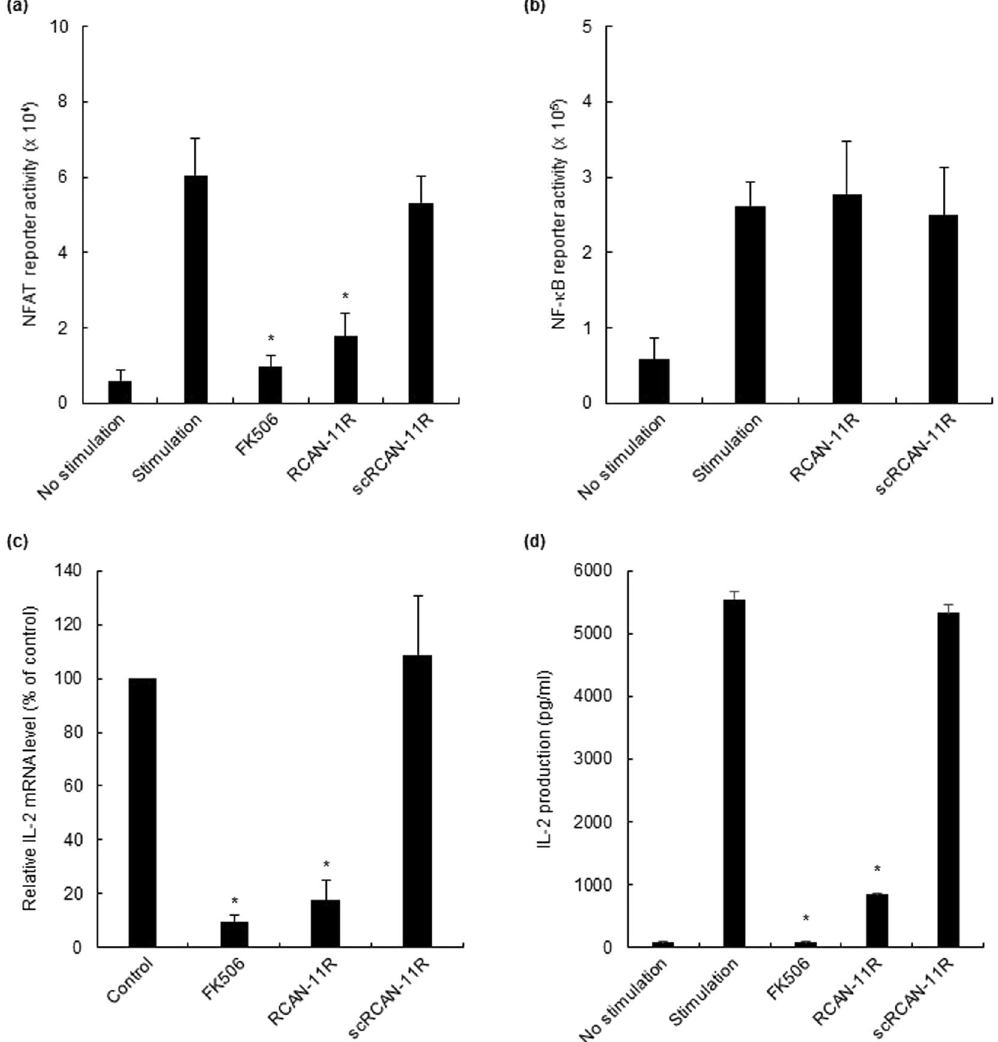
Figure 2. The inhibition of NFAT reporter activity and the production of IL2. ( a , b ) NFAT ( a ) and NF- κ B ( b ) reporter activity. Jurkat cells were electroporated with 5 μ g of pNFAT-SEAP or pNF- κ B-SEAP, respectively. The cells were incubated with 1 μ M FK506 or 20 μ M RCAN-11R/scRCAN-11R for 1 h, and stimulated with 200 nM PMA and 4 μ M ionomycin for 12 h. ( c ) The inhibition of IL-2 transcription. Jurkat cells were treated with 1 μ M FK506 or 20 μ M RCAN-11R/scRCAN-11R for 1 h, then with 200 nM PMA and 4 μ M ionomycin for an additional 12 h. The cells were subjected to a quantitative RT-PCR. ( d ) The inhibition of IL-2 production. Jurkat cells were treated with 1 μ M FK506 or 20 μ M RCAN-11R/scRCAN-11R for 1 h and then incubated with 200 nM PMA and 4 μ M ionomycin for an additional 12 h. * p < 0.01 in comparison to stimulation (control) without treatment of FK506 or peptides. The values represent the mean ± SE of five independent